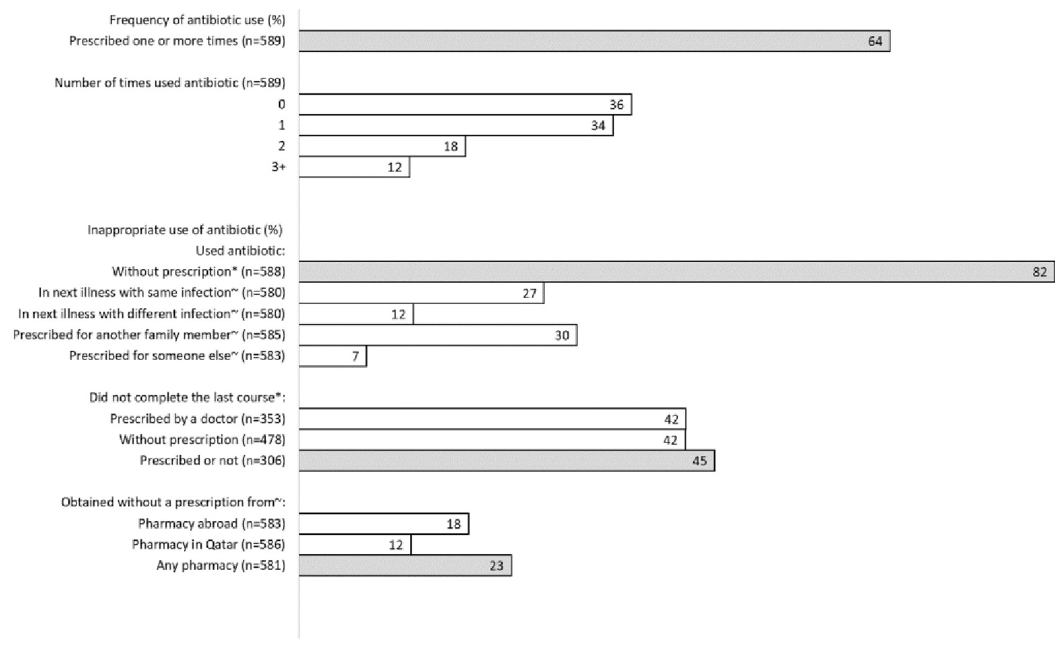
Fig 1. Degree of antibiotic prescribing and inappropriate antibiotic